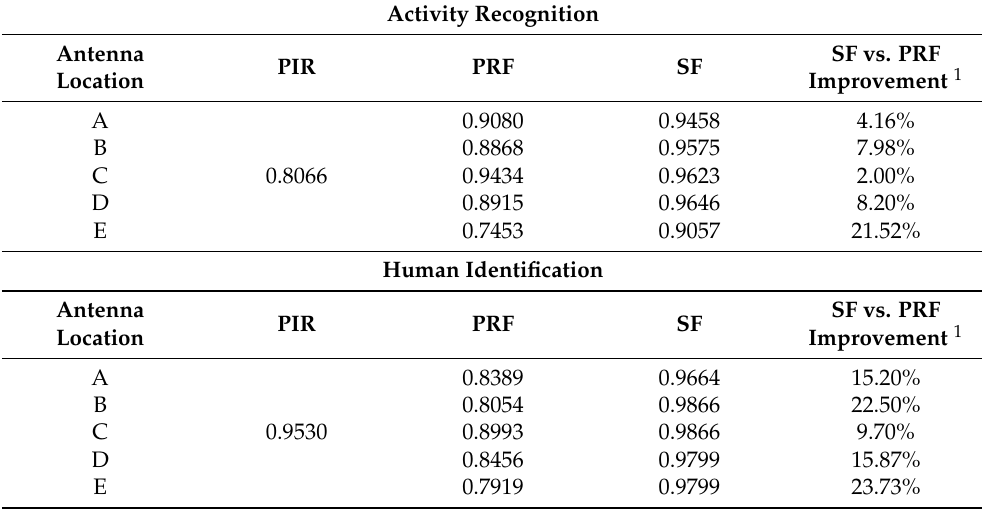
Table 3. Comparison between sensor fusion and SDR only in different locations.